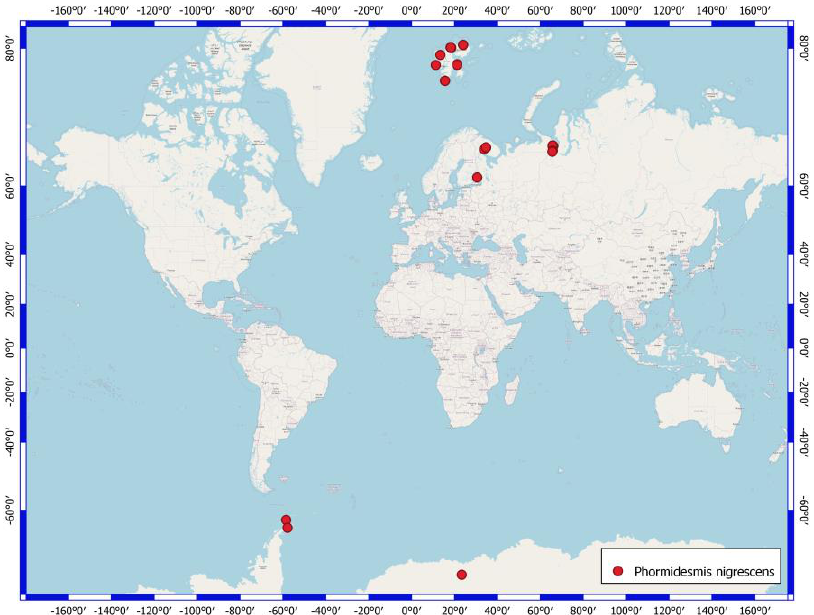
Figure 11. Distribution of Phormidesmis nigrescens according to information system “L”